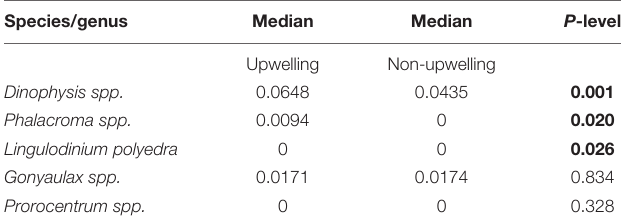
TABLE 2 | Summary of the Mann–Whitney U -test results of the potential HAB species contributions between samples of upwelling and non-upwelling conditions; significant results at p < 0.05 are highlighted in bold, N = 143 (upwelling) and N = 123 (non-upwelling).